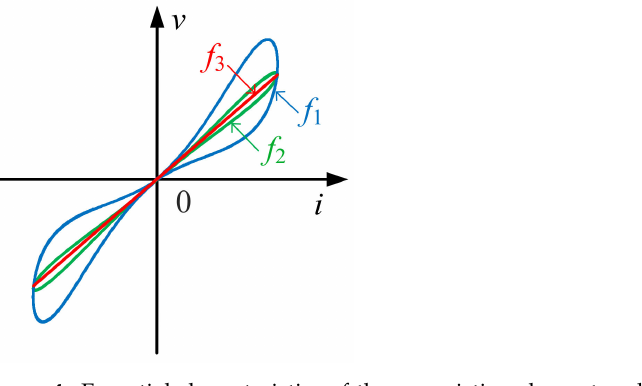
Figure 4. Essential characteristics of the memristive element and system under bipolar periodic excitation signals ( f 1 < f 2 < f 3 and f 3 → ∞